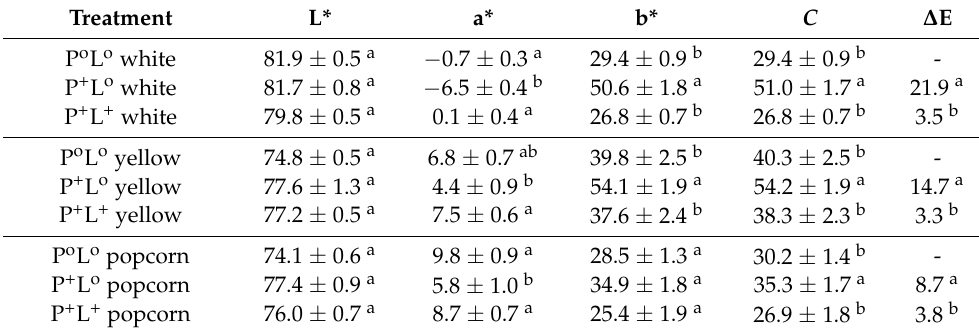
Table 1. Colour parameters in maize kernels submitted to different treatments.